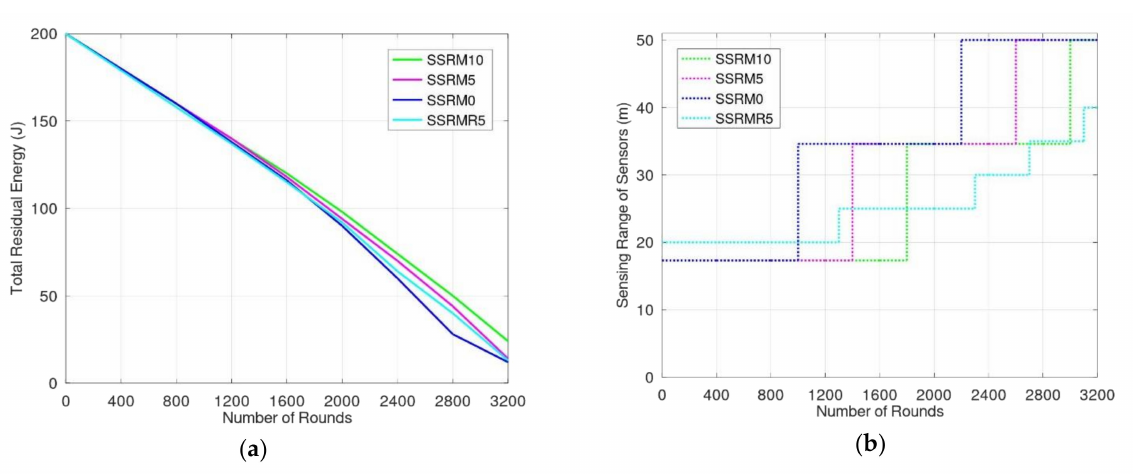
Figure 9. ( a ) Energy consumed by sensors according to monitoring time for di ff erent unmonitored region rates; ( b ) sensing range of sensors adjusted in these